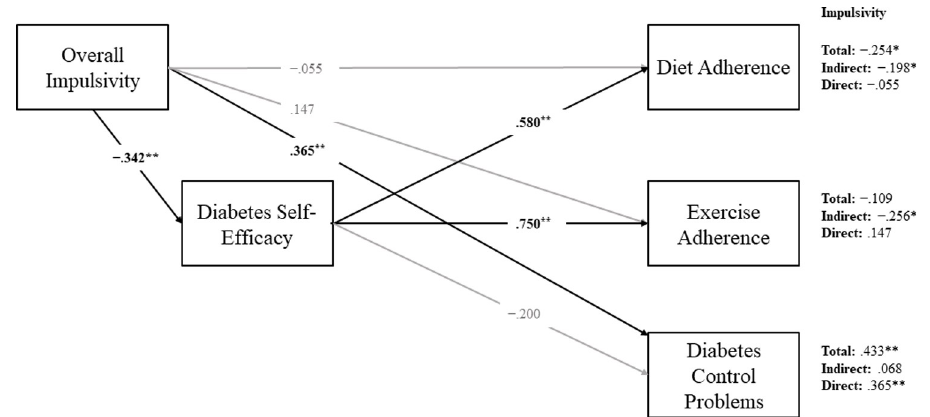
Fig 2. Path model estimating direct and indirect effects of impulsivity on self-care outcomes among individuals diagnosed with Type 2 diabetes, controlling for BMI. Completely standardized maximum likelihood parameter estimates shown. Unstandardized slopes of the indirect effects along with the bias-corrected 95% bootstrapped confidence intervals are provided in text. � p < .05, �� p < .01.